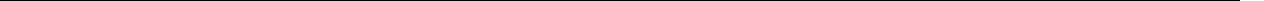
Fig. 2 Association of decreased AGGF1 and increased ER stress signaling. a Representative immunohistochemical images for AGGF1 expression ( left ) in heart sections from eight dilated cardiomyopathy (DCM) patients and three controls (NC) and quanti fi cation ( right ; ** P < 0.01). Scale bar , 100 μ m. b Western blot analysis for AGGF1 and ER stress signaling markers using protein extracts from eight DCM patients and three controls (NC group: n = 3; DCM group: n = 8, ** P < 0.01). c Real-time RT-PCR analysis for the level of AGGF1 mRNA in patients ’ hearts (* P < 0.05). d Representative immunohistochemical images for AGGF1 expression ( left ) in heart sections from TAC mice vs. control Sham mice (12 weeks of age, 20 – 25 g) and quanti fi cation ( right ; n = 5/group, ** P < 0.01). Scale bar , 50 μ m. e Western blot analysis for AGGF1 and ER stress signaling markers using protein extracts from mice with ISO treatment vs. mice with control vehicle (Veh) treatment ( n = 6/group, ** P < 0.01). f Real-time RT-PCR analysis for the level of AGGF1 mRNA using cDNA extracts from mice with ISO treatment vs. mice with control vehicle (Veh) treatment ( right ; n = 5/group, ** P < 0.01). g Western blot analysis for AGGF1 and ER stress signaling markers using protein extracts from H9C2 cells treated with or without ISO ( n = 6/group, ** P < 0.01). h Real-time RT-PCR analysis for the level of AGGF1 mRNA using RNA extracts from H9C2 cells treated with or without ISO ( n = 3/group, ** P < 0.01). Data are shown as the mean ± s.d. from at least three independent experiments. Statistical analysis was carried out by a Student ’ s two-tailed t